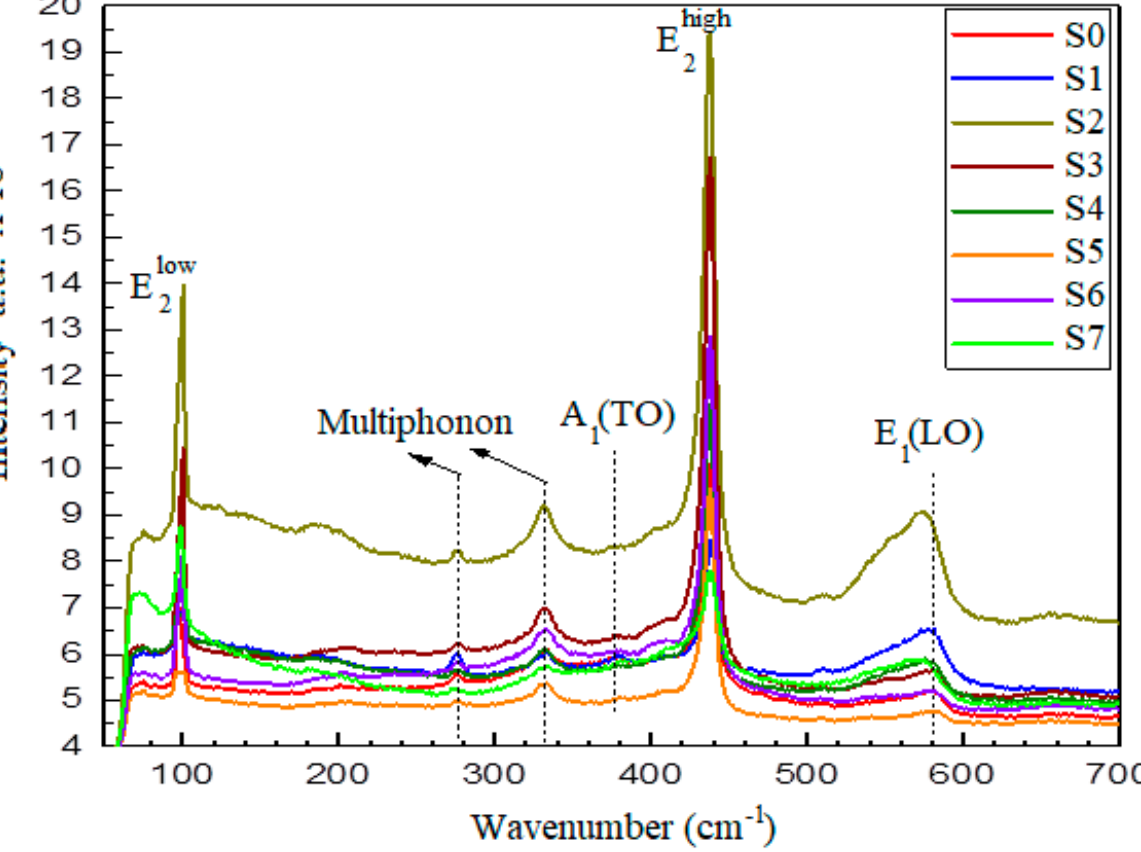
Figure 5. Raman spectra of the pure and B doped ZnO films. The peaks at both 278 and 336 cm − 1 are assigned to the A 1 symmetry modes and multiple-phonon scattering processes or [E 2 (high)-E 2 (low)]. The peak at 579 cm − 1 is assigned to the E 1 (LO) mode and is related to host defects such as V O and Zn i . The peak at 381 cm − 1 corresponds to the A 1 (TO) modes. As a result of that, no Raman peak of boron appeared in the spectrum of the B-doped ZnO